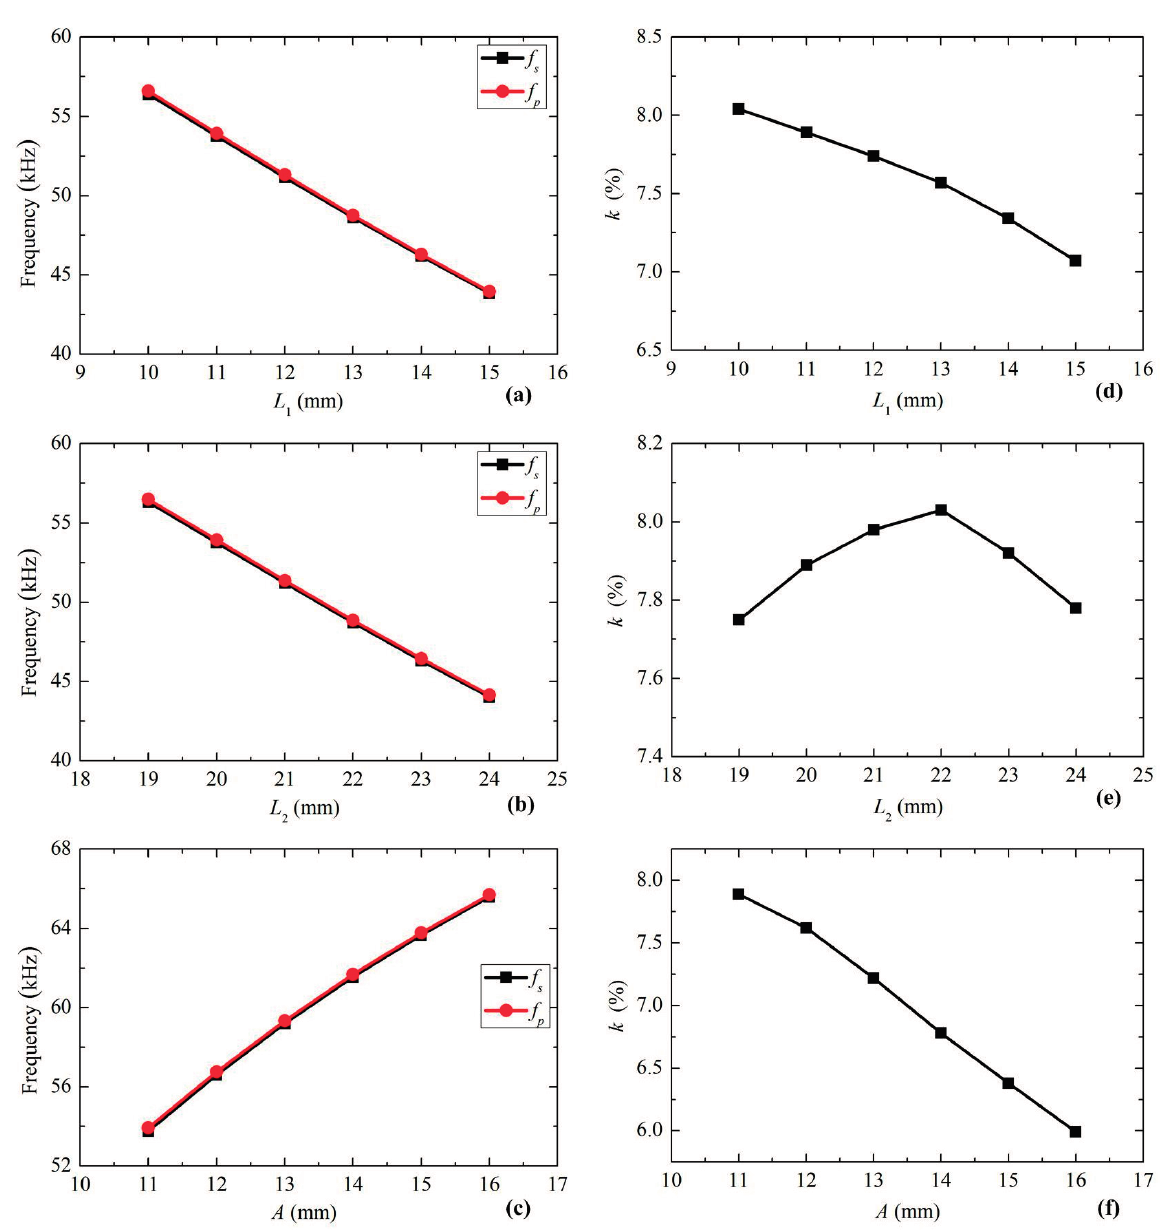
Figure 4. Parameter sensitivities of the resonance frequencies and electromechanical coupling